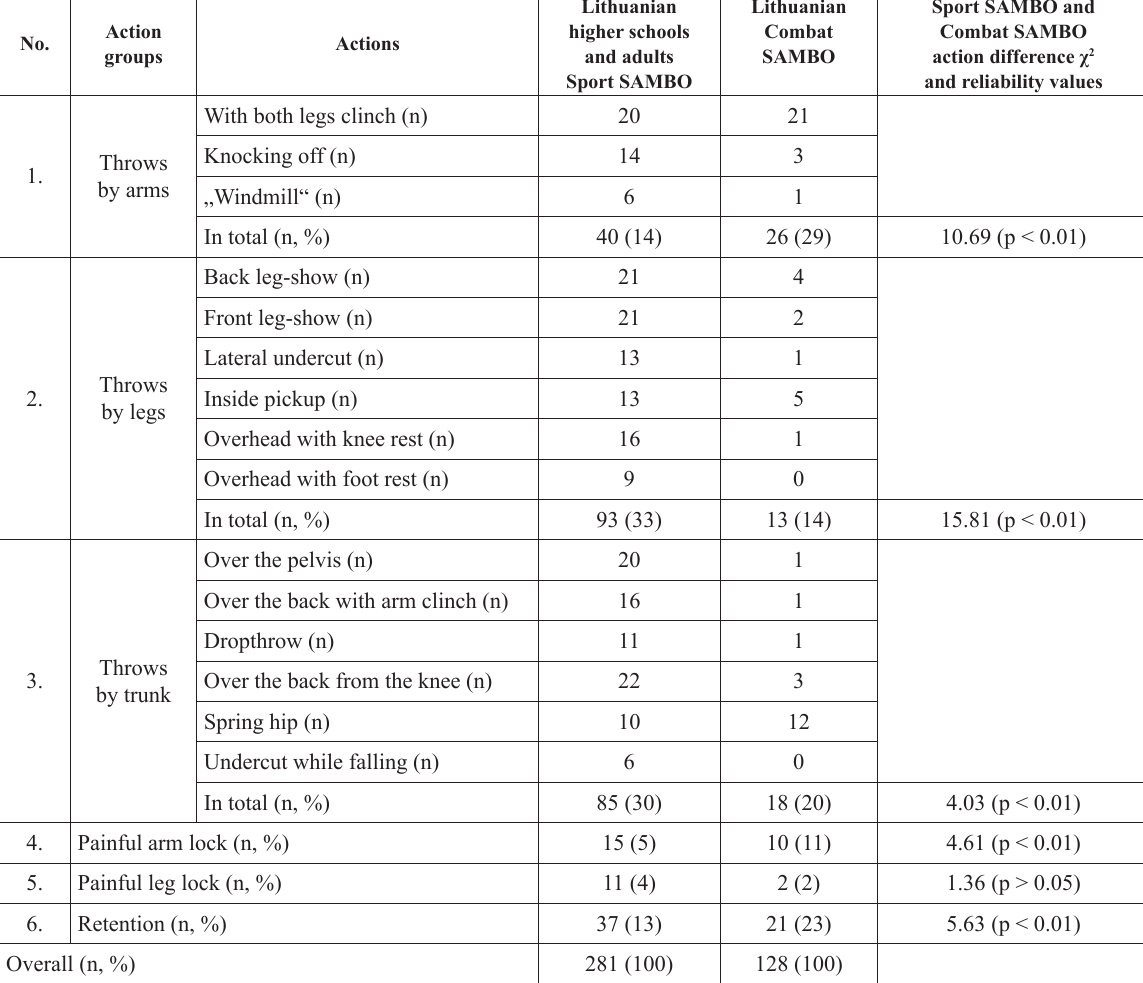
Table 2. Distribution of actions performed at Lithuanian Sport SAMBO and Combat SAMBO contests; reliability of the value differences